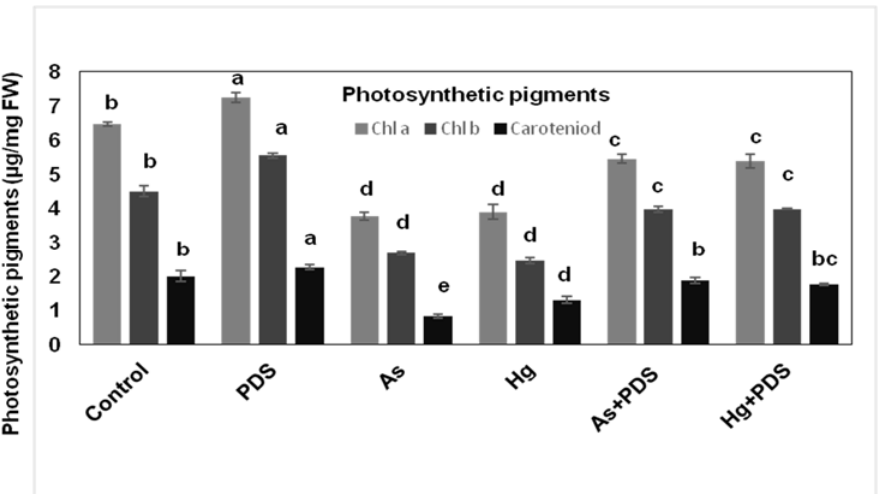
Figure 3. Evaluation of photosynthetic pigments under PDS (2000 ppm) and As and Hg ‐ treated wheat seedlings. The photosynthetic activity was measured in wheat seedlings after 7 days of germination by selecting three random plants from each replicate and treatment. Chlorophyll a, b and carotenoids were increased under PDS alone and with As and Hg in combined form, but were decreased under As and Hg ‐ treated plants. All data were analyzed using one ‐ way ANOVA, with multiple comparisons using the LSD test at a significance level of p ≤ 0.05 ( n = 5). The different lowercase letters represent homogeneous subsets and indicate the statistical significance according to Fisher’s LSD at level p ≤ 0.05.